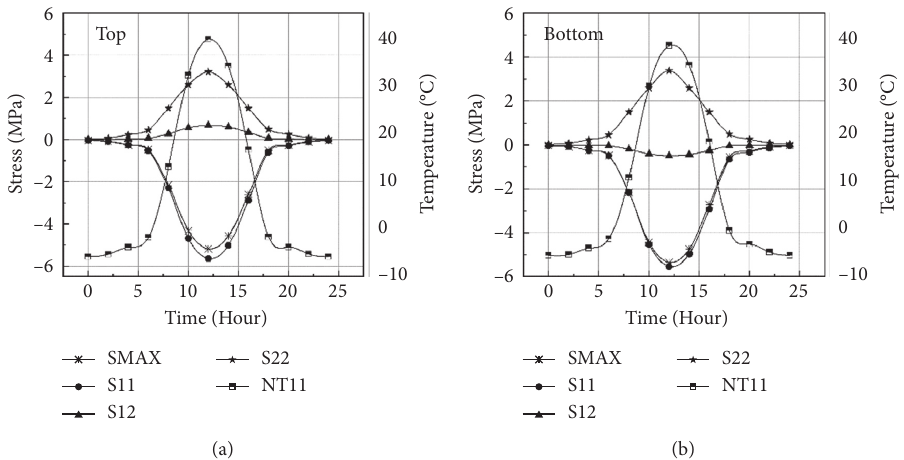
Figure 9: Time-history response curve of stresses above void area in the “void” condition in the winter: (a) slab top and (b) slab bottom.